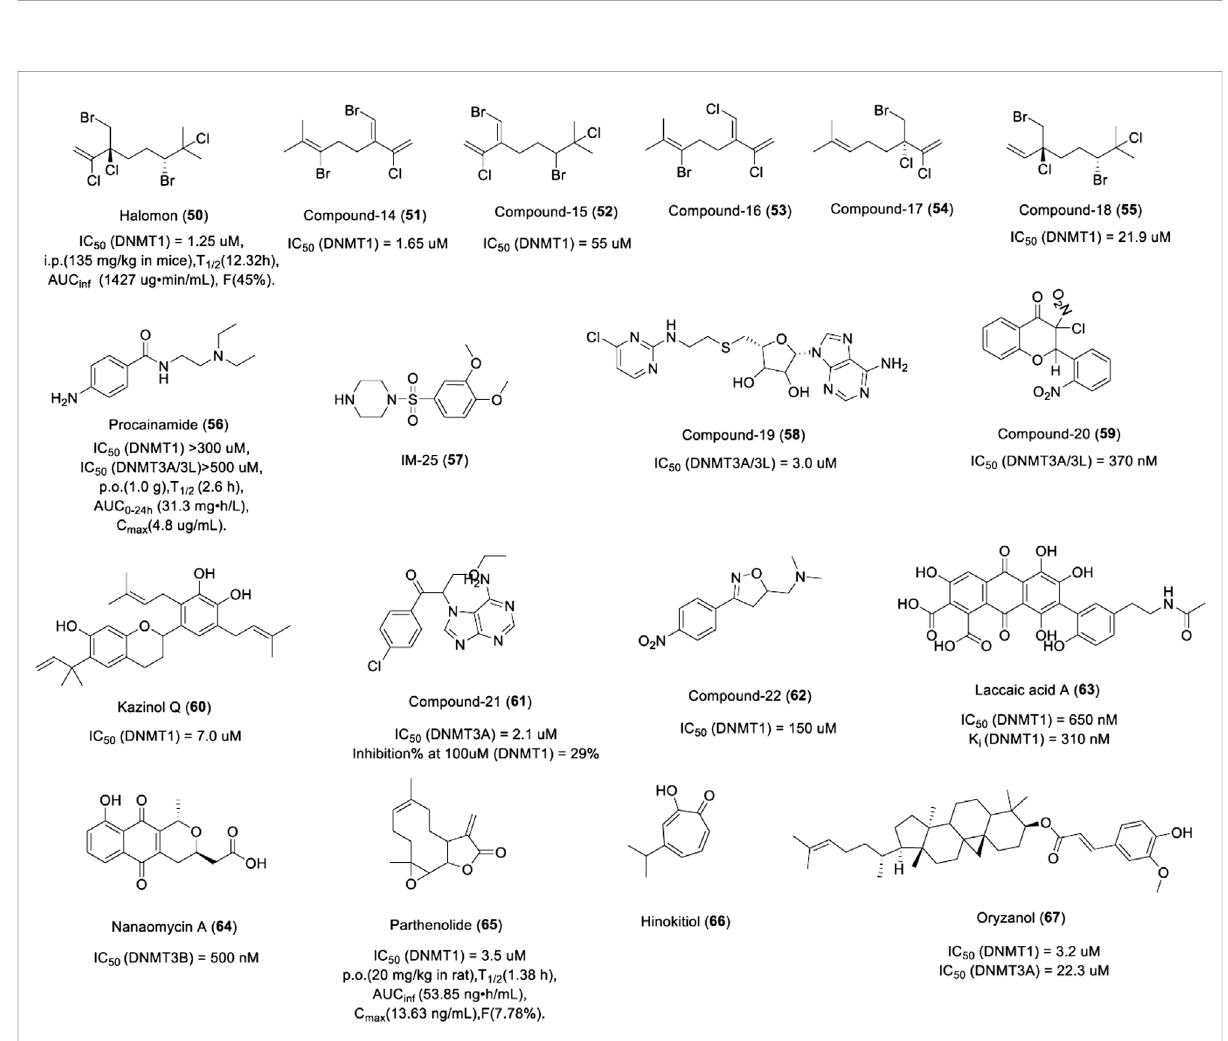
FIGURE 10 Chemical structure of other DNMTis in